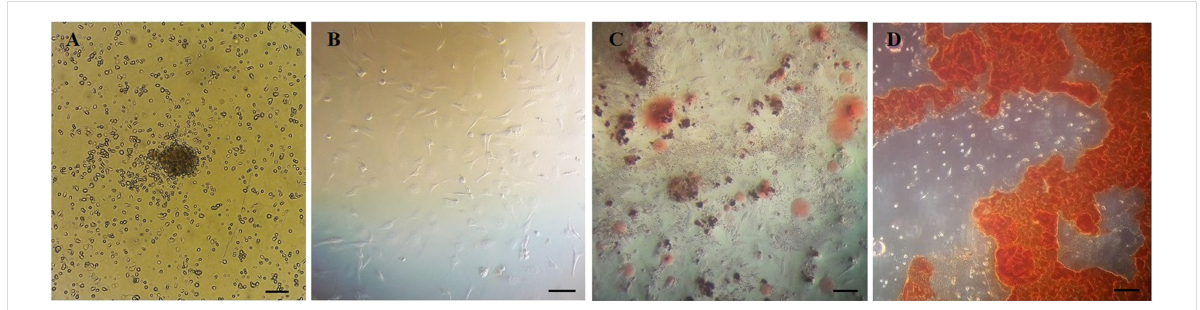
Figure 1: Morphology of BM-MSCs; (A) Fibroblast-like morphology of cells that appear 24 h after cell seeding (bar = 20 μ m); (B) more confluent cells at the end of seven days of culture (bar = 20 μ m); (C) lipid vacuoles were stained by Oil-Red O after adipogenesis (bar = 20 μ m); (D) mineralized cell aggregates was stained by Alizarin red at the end of osteogenic differentiation (bar = 20 μ m).